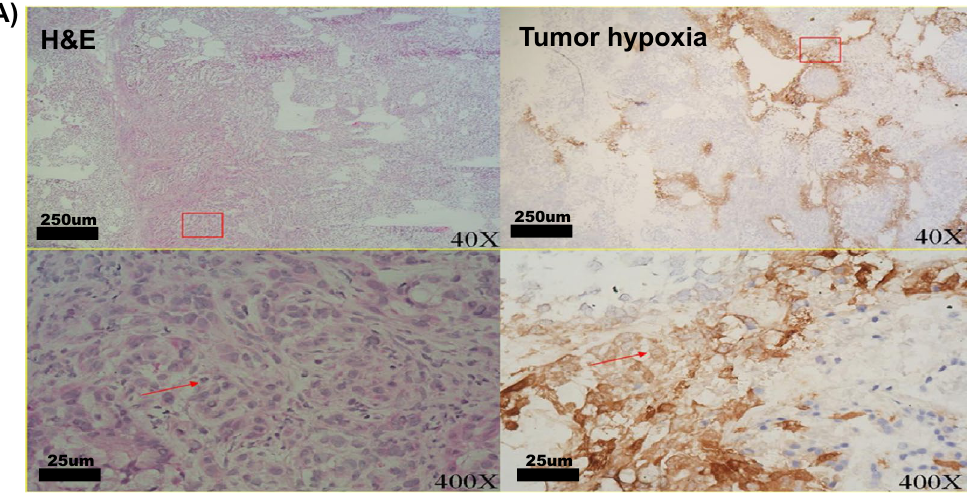
Figure 2. Immunohistochemical staining of tumor sections from A549- transferred SCID mice. ( A ) Haematoxylin & Eosin (H & E) staining and immunostaining of Hypoxyprobe-1 probe of A549 tumor frozen sections after 45 days of tumor transfer. (H & E: H and E staining; tumor hypoxia: Immunostaining of Hypoxyprobe-1 probe) ( B ) Comparisons of tumor hypoxia in groups of mice after 14 and 28 days of HBOT. (Control-0: control mice at the first date comparing with HBOT mice; HBO 2 -0: mice receiving the first date of HBOT; Control-14: control mice after 14 days comparing with HBOT mice; HBO 2 -14: mice after 14 days of HBOT; Control-28: control mice after 28 days comparing with HBOT mice; HBO 2 -28: mice after 28 days of